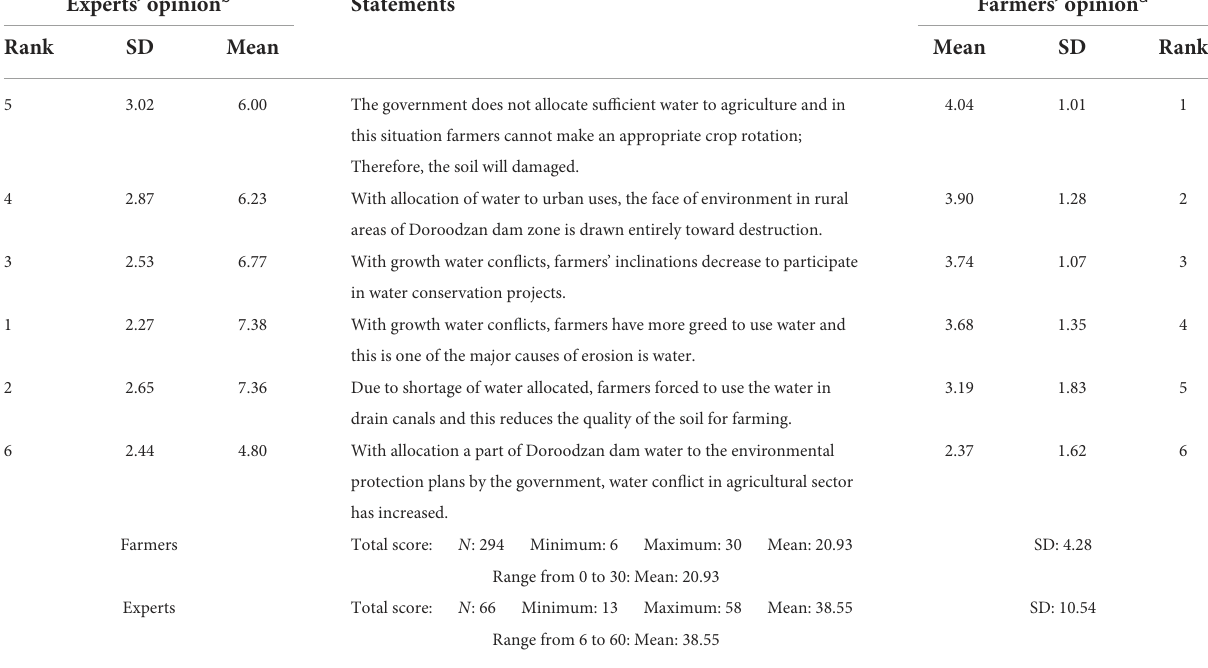
TABLE 5 Environmental scarcity and